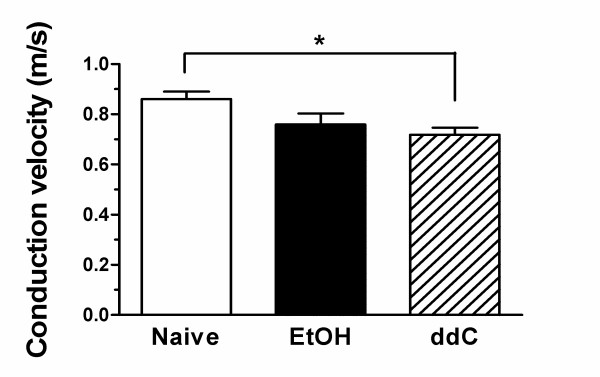
Mean conduction velocities (0.86 ± 0.03, 0.76 ± 0.04, 0.72 ± 0.03 m/sec) of C-fibers from the three groups of rats (i.e., naive, ethanol (EtOH) and ddC, respectively) were significantly different (one way ANOVA, p < 0.05). The conduction velocity of C-fibers from the ddC group (n = 18) was significantly lower than that of control rats (n = 38, p < 0.05) while the conduction velocity was similar between EtOH (n = 15) and control groups (p > 0.05).